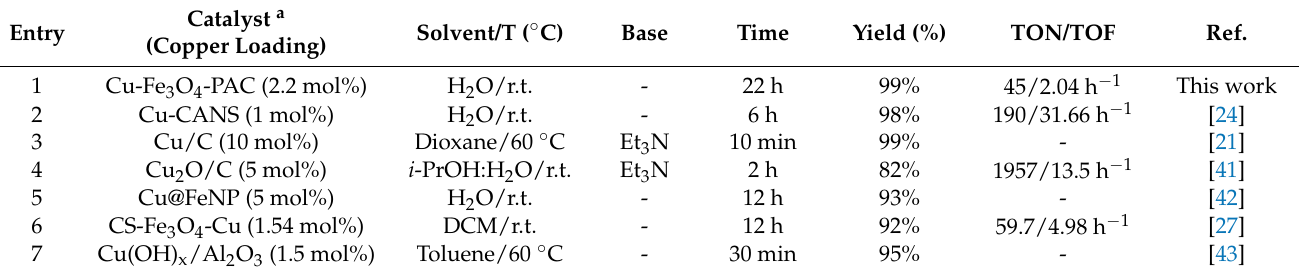
Table 3. Comparison of the catalytic activity of the Cu-Fe 3 O 4 -PAC catalyst with other heterogeneous copper-based catalytic systems reported in the literature.